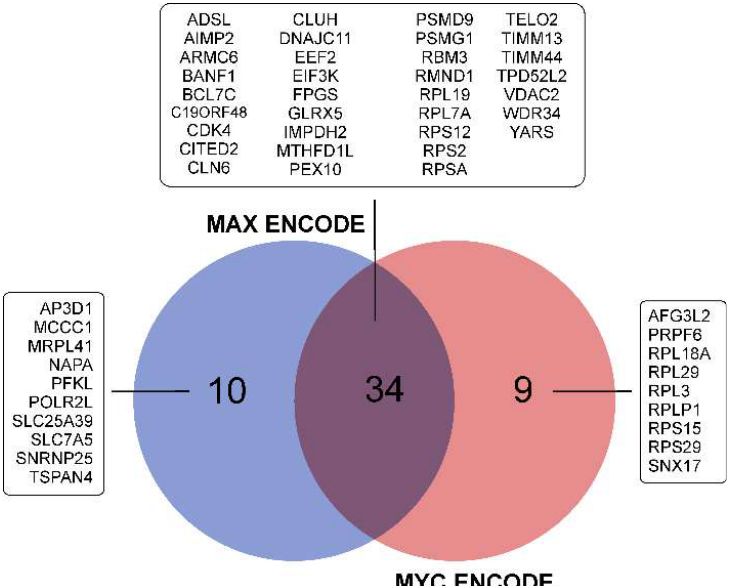
Figure 7. Venn diagram showing intersections of sets of glioma NS-downregulated genes controlled by MYC and MAX transcription factors. Illustrated Enrichr results of glioma NS downregulated genes analyzed using the “ENCODE and ChEA Consensus TFs from ChIP-X” library.